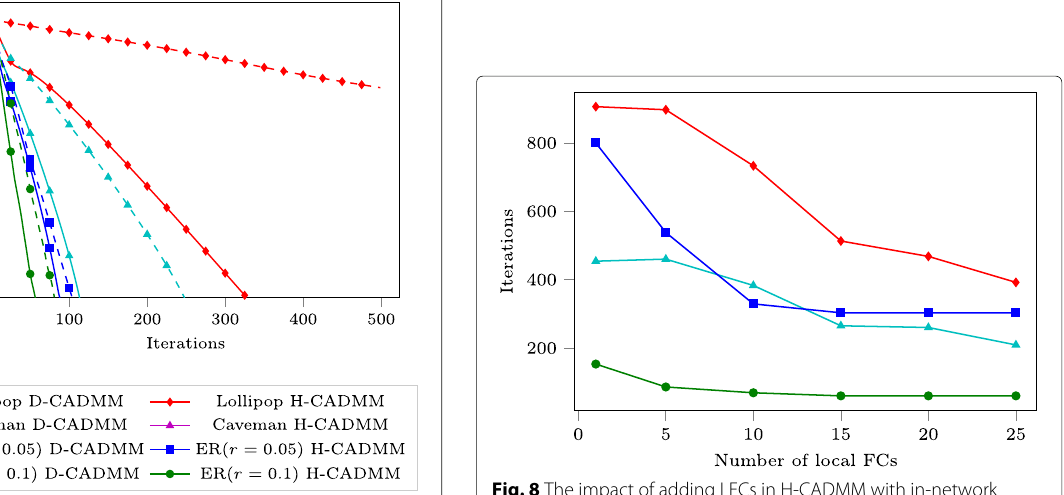
Fig. 7 Effects of in-network acceleration on the lollipop graph, the caveman graph, and two Erd˝os Rényi random graphs